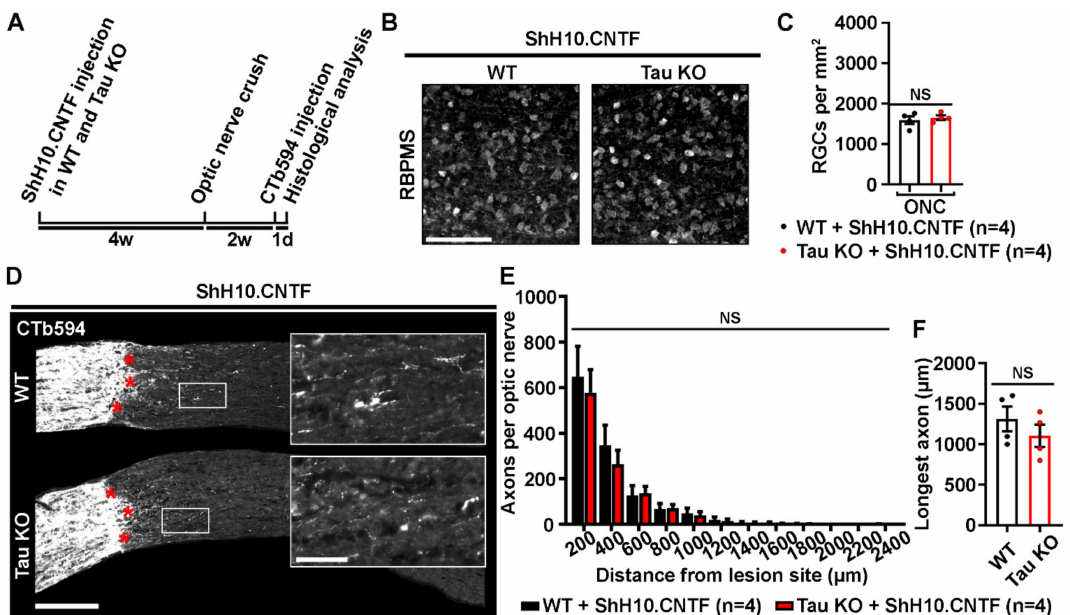
Figure 4. Tau deletion does not modulate CNTF-induced survival and axonal growth of injured retinal ganglion cells. ( A ). Experimental timeline. ShH10.CNTF virus was injected in the vitreous of the left eye to activate retinal ganglion cell growth mechanisms at 4 weeks before left ONC. Two weeks after injury, axons were traced with CTb594 the day before histological analysis. ( B ). Influence of Tau deletion on the survival of retinal ganglion cells (RGCs) at 2 weeks after injury. Flat-mounted retinae were immunostained for RNA-Binding Protein with Multiple Splicing (RBPMS) to determine RGC density in WT and Tau KO mice. Scale bar: 50 µ m. ( C ). Quantitative analysis of RGC survival. The density of RGCs did not di ff er between WT and Tau KO mice ( n = 4 mice per group). Data are expressed as mean / mm 2 ± S.E.M. Statistics: Student’s t-test. NS: Non-significant. ( D ). Influence of Tau on ShH10.CNTF-induced axonal outgrowth. Axons were anterogradely traced by intravitreal injection of CTb594. The growth of injured RGC axons was examined after the lesion site (red stars) in 10- µ m thick optic nerve cryosections. Close-up pictures show elongating axons beyond the injury site. Scale bars: 250 µ m, close-up: 50 µ m. ( E ). Quantitative analysis of axonal outgrowth. The quantification of the number of axons per optic nerve at distances ranging from 200 to 2400 µ m past the lesion site did not show any di ff erence between lesioned WT and Tau KO optic nerves ( n = 4 mice per group). Data are expressed as mean ± S.E.M. Statistics: Student’s t-test. NS: Non-significant. ( F ). Measurement of